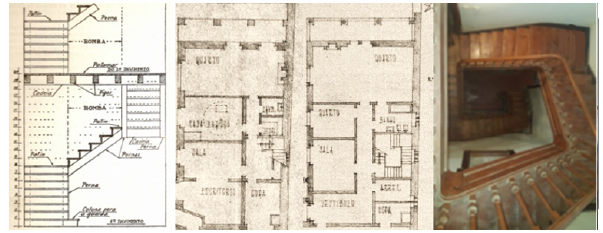
Figure 24. Drawings, pictures and model of interior wooden